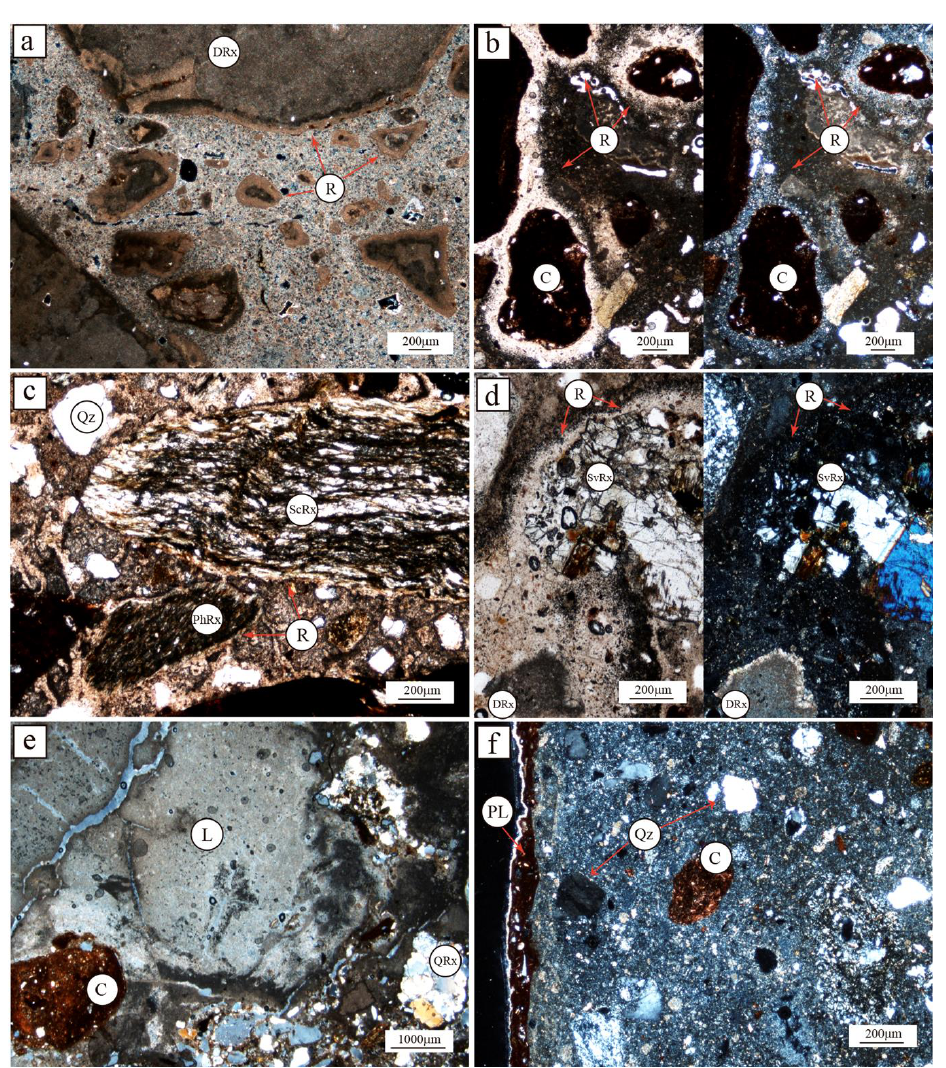
Figure 4. Photomicrographs showing the most representative microtextures of the lime mortars from Amaiur Castle cistern. ( a ), ( b )-left, ( c ) and ( d )-left: plane polarized light mode (PPL). ( b )-right, ( d )-right, ( e ) and ( f ): crossed-polarized light mode (XPL). C: ceramic; DRx: dolostone; L: lime lump; PhRx: phyllite; PL: pigmented layer; QRx: quartzite; Qz: quartz; R: reaction zone; ScRx: Schist; SvRx: subvolcanic rock.